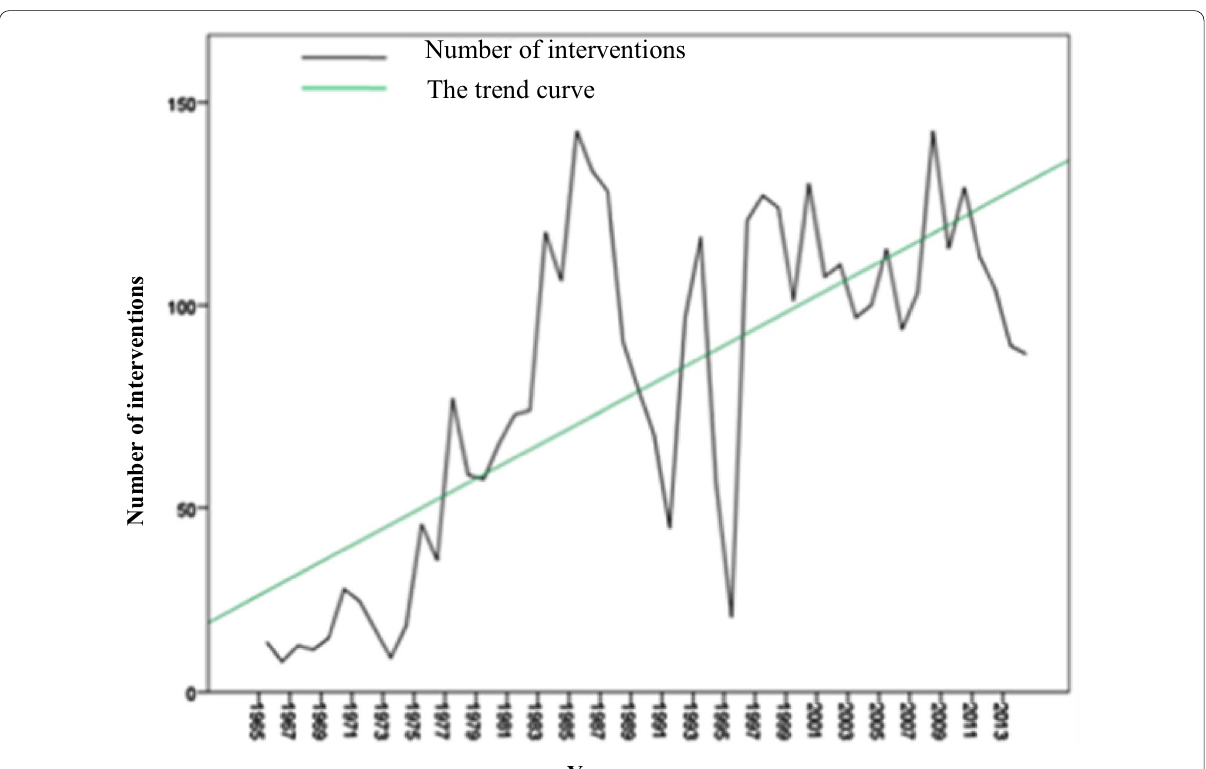
Fig. 1 Annual evolution of the number of operative interventions for urolithiasis between 1965 and